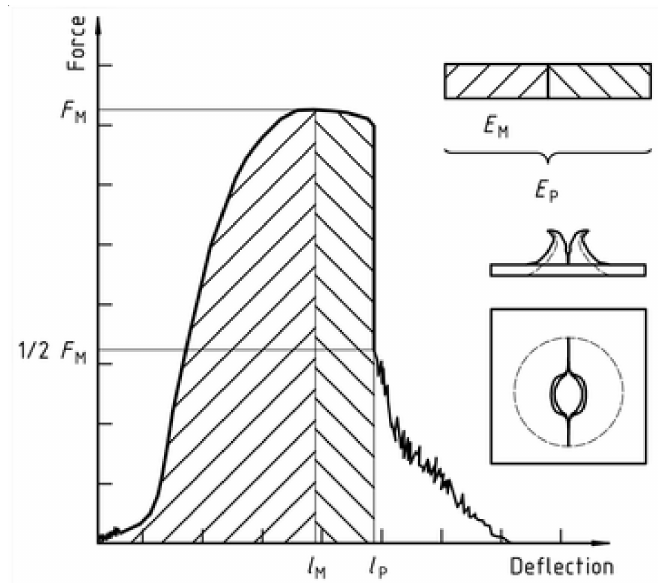
Figure 9. Example of force-deflection diagram for a ductile, with crease, specimen. Table 6. Impact puncture results of nanocomposite